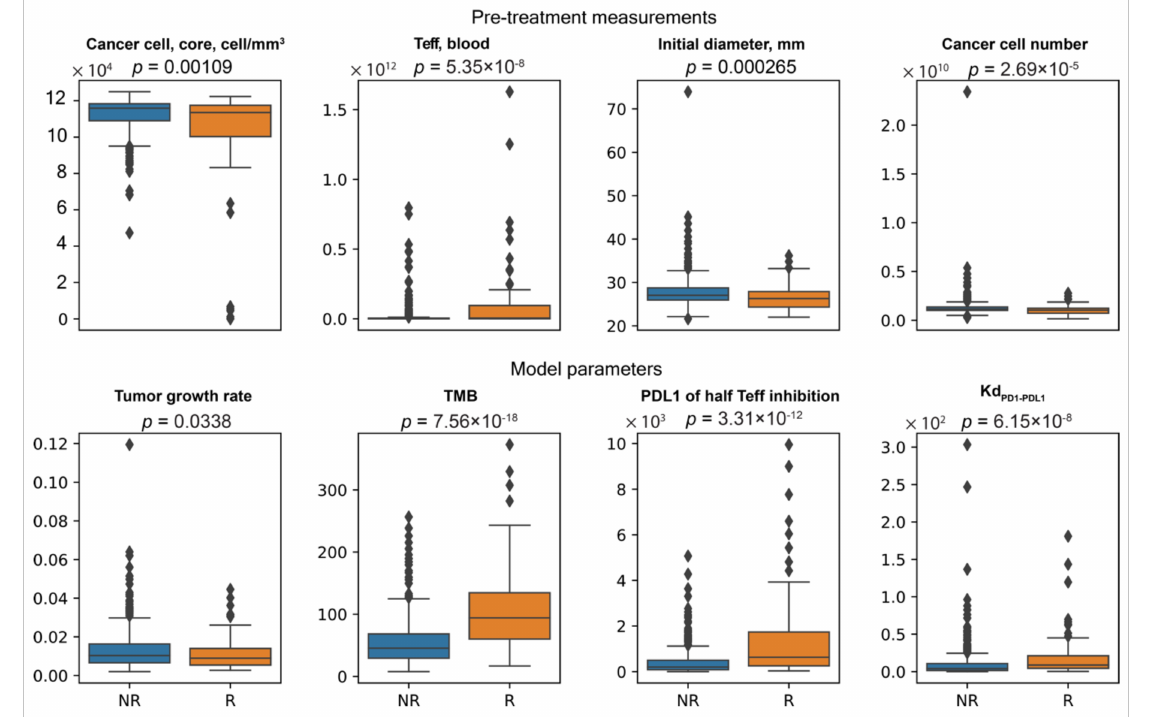
Figure 12. Distribution of biomarker values in responders vs.